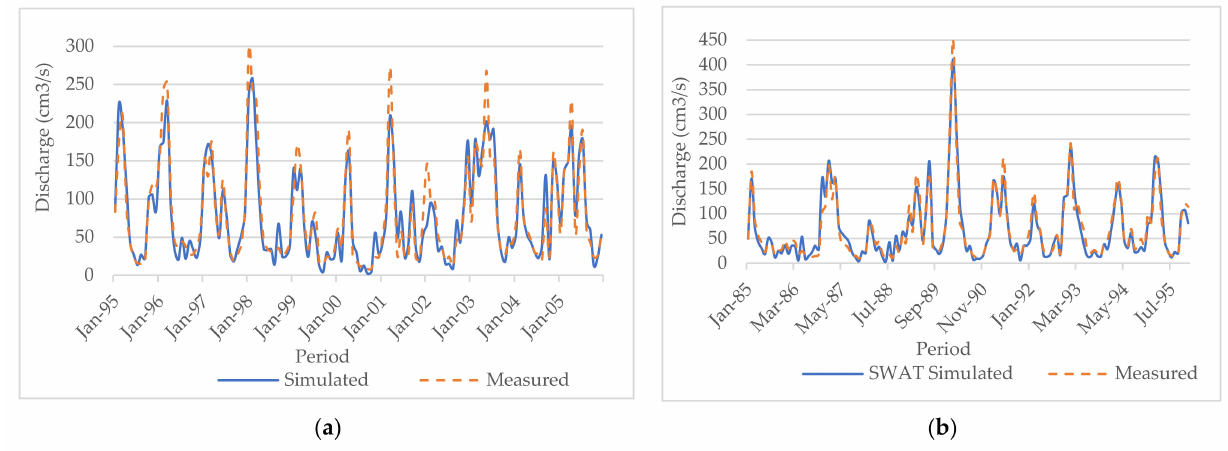
Figure 7. Monthly streamflow hydrographs for ( a ) calibration and ( b ) validation periods at USGS gage 02425000, on the Cahaba River near Marion